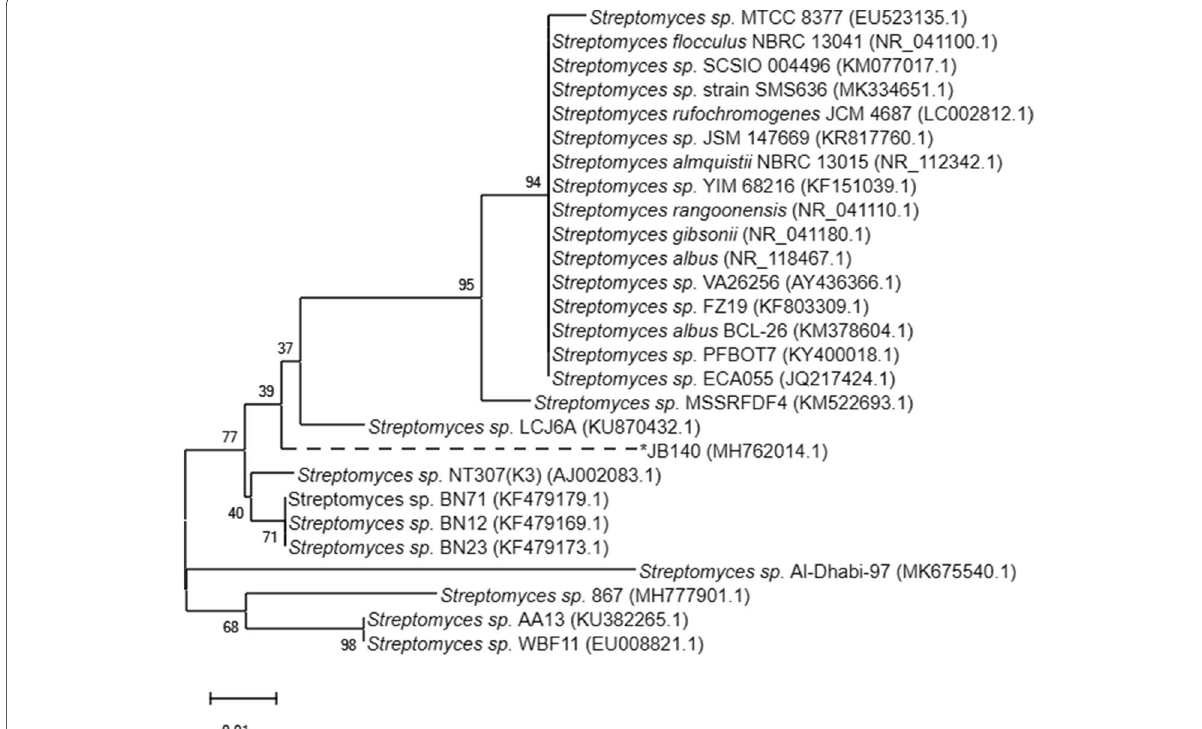
Fig. 4 Evolutionary relationship of JB140 was inferred using the neighbor-joining method. The tree is drawn to scale, with branch lengths in the same units as those of the evolutionary distances used to infer the phylogenetic tree. The evolutionary distances were computed using the Kimura 2-parameter method. The rate variation among sites was modeled with a gamma distribution (shape parameter conducted in MEGA